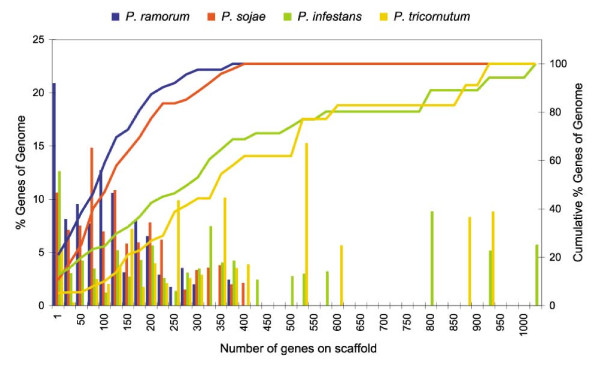
Quality of the genome assembly for the Phytophthora species and for the diatom Phaeodactylum tricornutum. The histograms represent the percentage of genes (left Y-axis) lying on a scaffold of a certain size, measured by the number of genes on a scaffold. The corresponding lines represent the cumulative percentage of genes (right Y-axis).